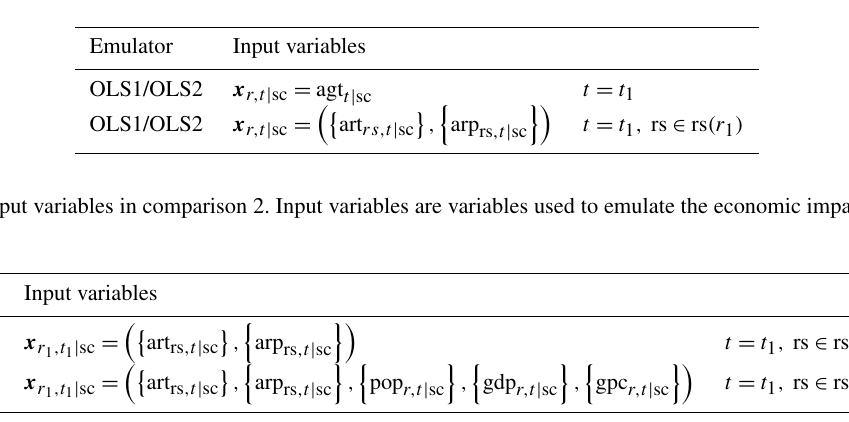
Table 3. Models and input variables in comparison 1. Input variables are used to emulate the economic impact in year t 1 in region r 1 for each sector.